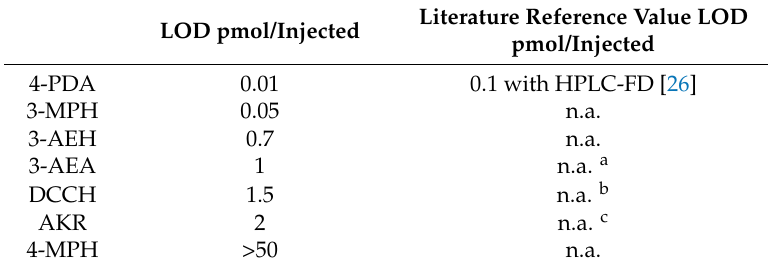
Table 1. Limit of detection (LOD, S/N > 3) for MGO derivatives of seven different reagents with LC-ESI-MS, estimated from factorial dilution series factor 3 involving concentrations below